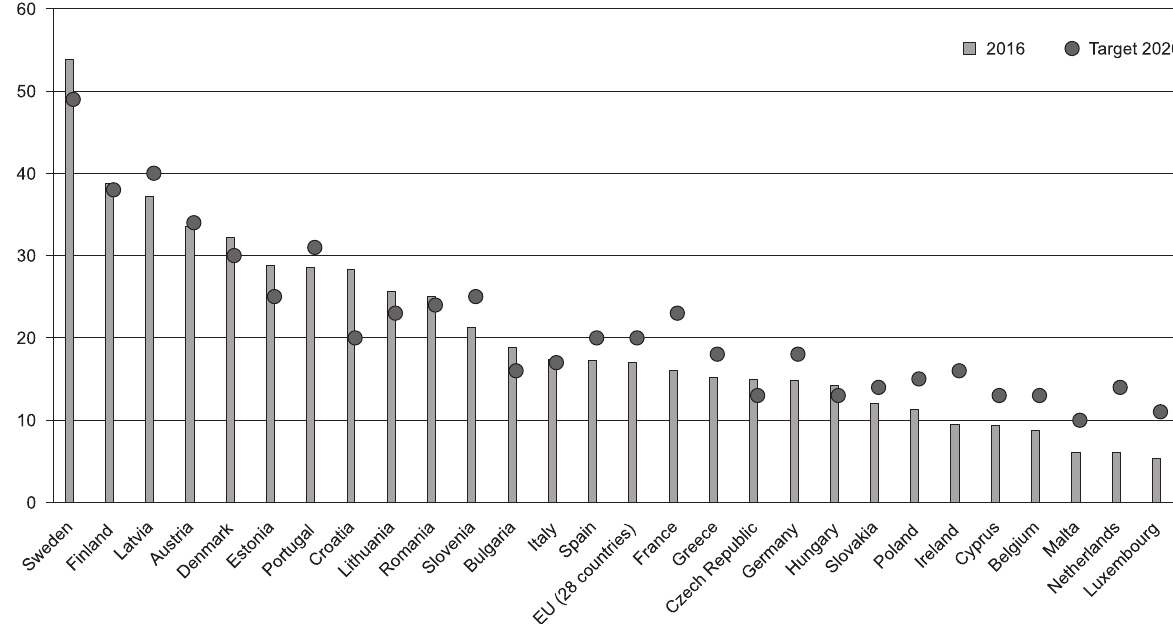
Fig. 1. The share of RES in gross final energy consumption in the EU countries together with the 2020 target. Source: own study based on Eurostat data,